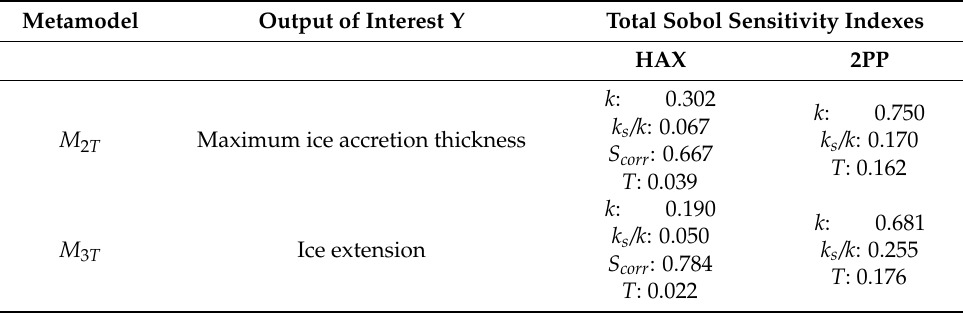
Table 8. Total Sobol sensitivity indexes for the temperature impact study.